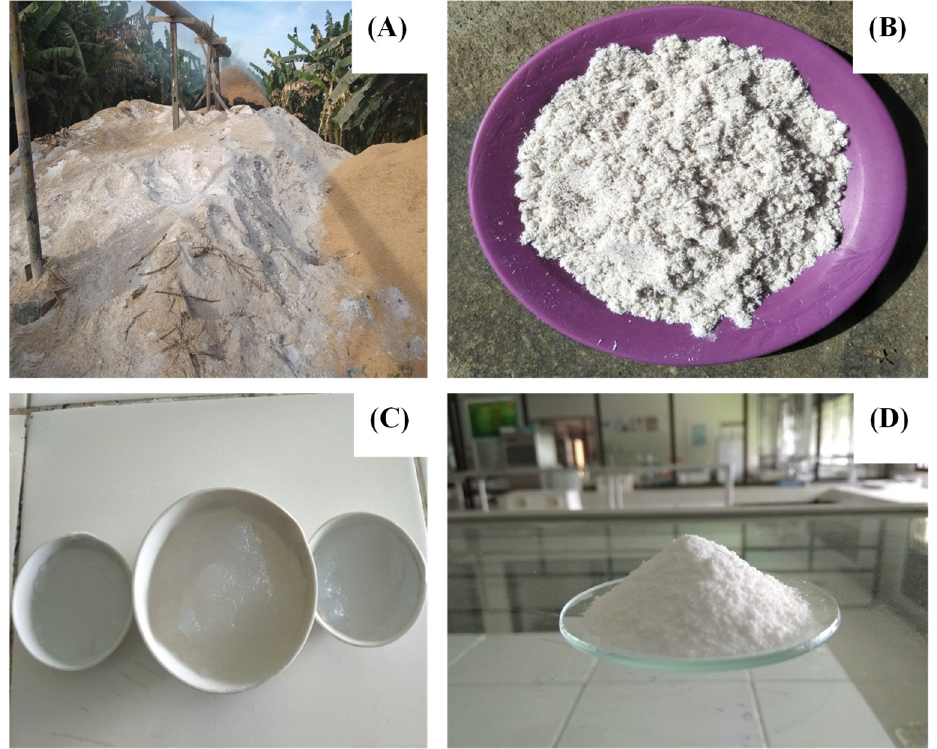
Figure 1. Rice husk ash can be processed into silica particles. ( A ) Bulky rice husk ash, ( B ) rice husk ash sample, ( C ) silica gel obtained from rice husk ash, ( D ) silica particle prepared from rice husk.